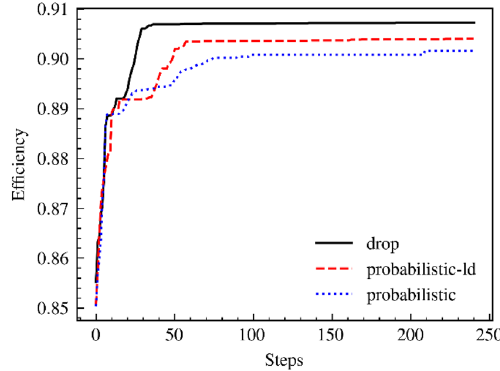
Fig. 12 Results with three different weighting strategies